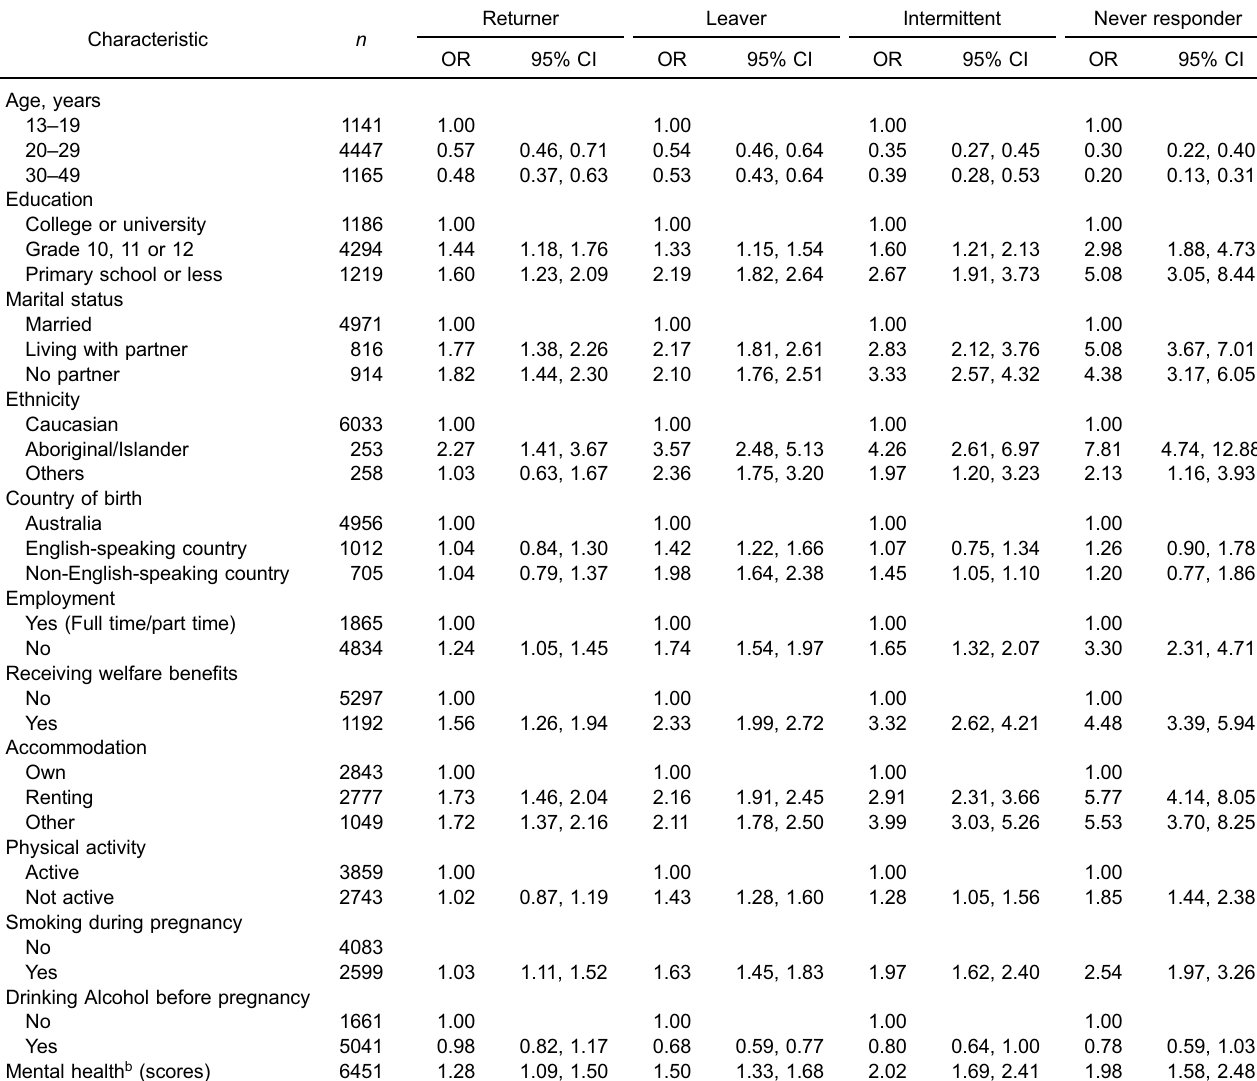
Table 1. Baseline predictors (crude ORs) of different patterns of loss to follow-up a